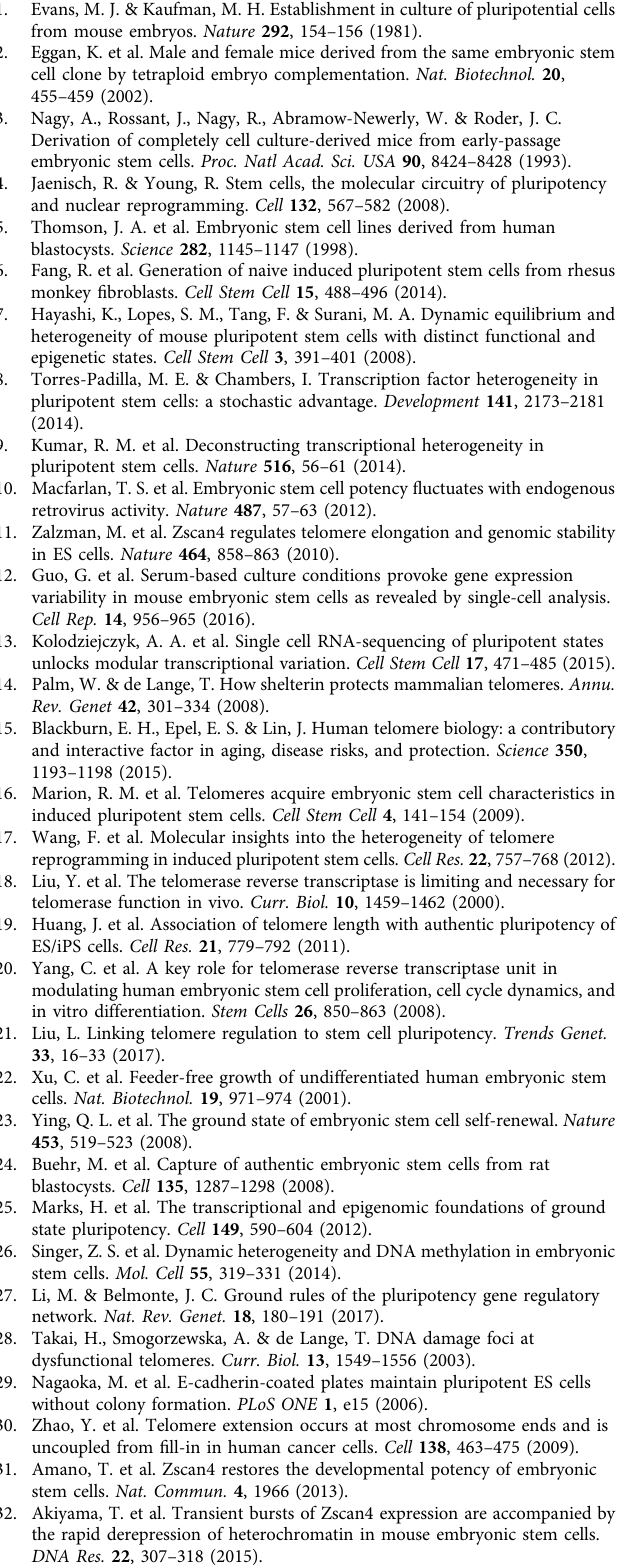
Table 6. For stable knockdown of Notch4 , shRNA sequences were synthesized and cloned into pSIREN-RetroQ, according to manufacturer ’ s instructions. A packa- ging cell line — Plat-E (5× 10 5 ) were transfected with 2 μ g plasmid using lipo- fectamine TM 2000. After 48 h, the supernatant of recombinant retrovirus was collected and used to transfected ESCs (2× 10 5 ). The clones were selected by 10 μ g/ ml puromycin, and survival ones were picked. The Notch4 KD sequences are listed in Supplementary Table